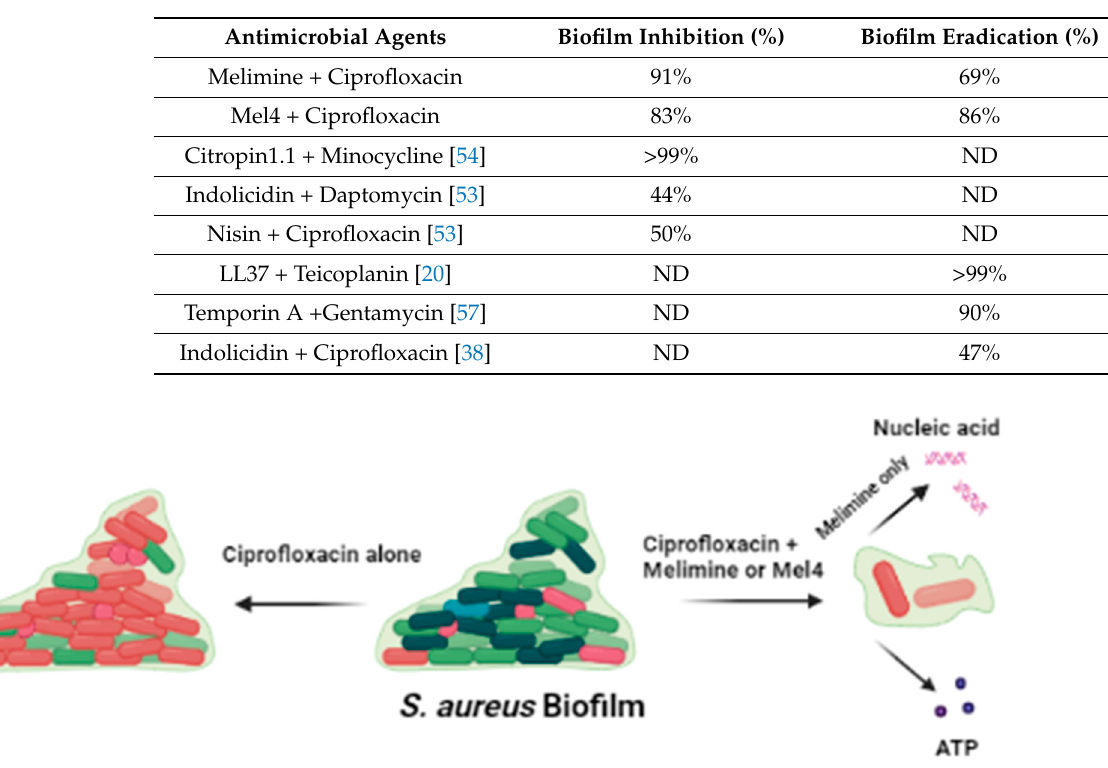
Figure 9. Effect of ciprofloxacin and peptides on the pre-formed biofilm of S. aureus. Ciprofloxacin alone did not disrupt the biofilm while when in combination with melimine or Mel4 it destroys the biofilm matrix following release of DNA/RNA (with melimine only) and ATP from biofilm cells.